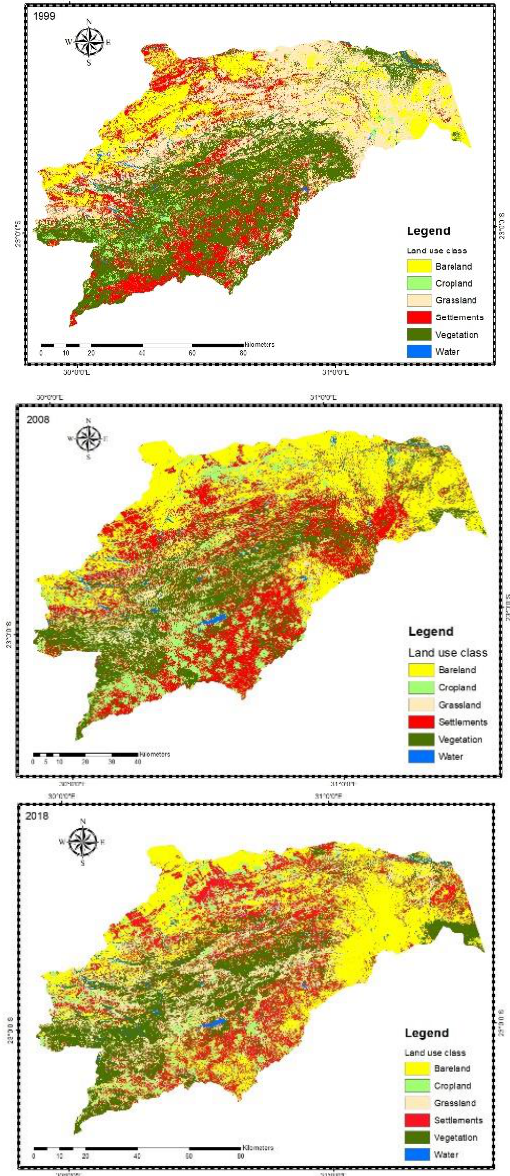
Figure 3: A graph showing the magnitude of areal coverage from land cover maps in (Ha)